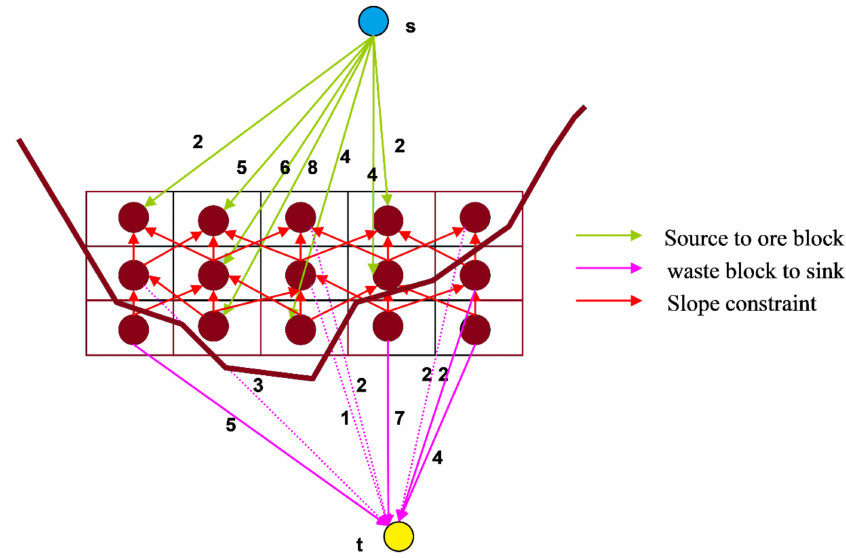
Figure 2. Pit limit calculation using the minimum directed graph